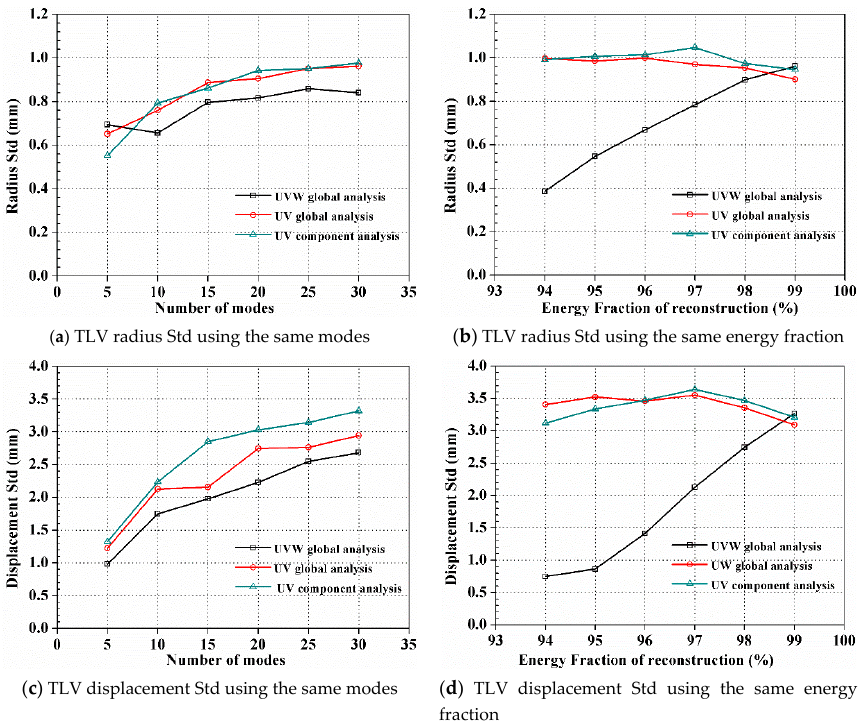
Figure 23. Statistics of instantaneous reconstructed flow field using first 10 modes at L/c = 1.1. Energies 2019 , 12 , x FOR PEER REVIEW